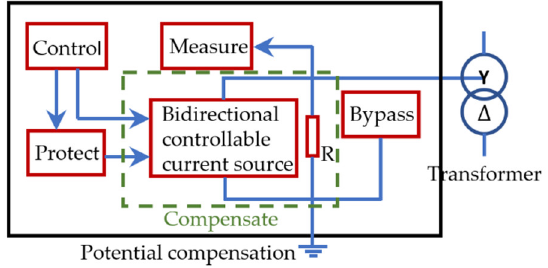
Figure 5. Schematic diagram of current injection method.